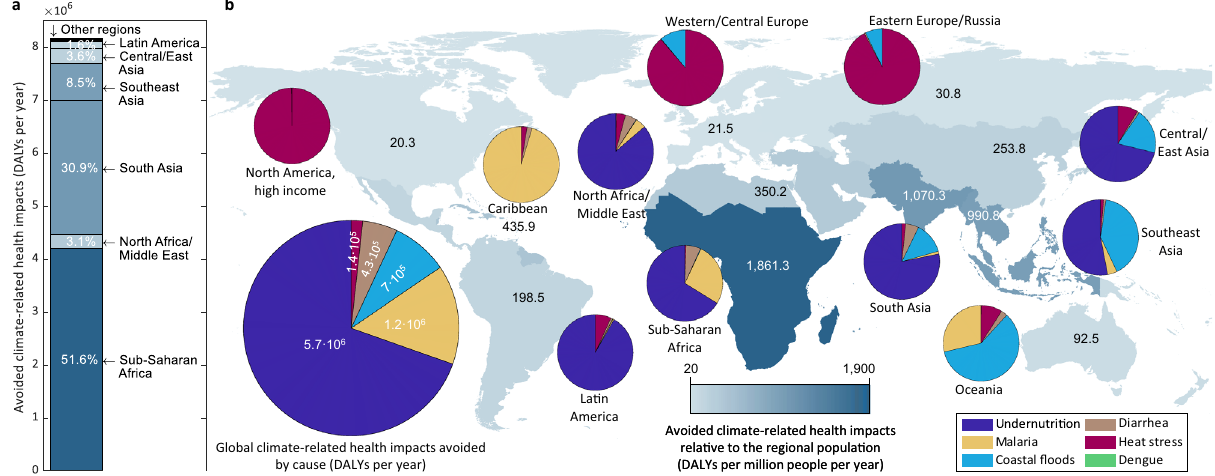
Fig. 4 Climate-related health effects avoided with respect to the baseline in the High-Temperature Liquid Sorbent Direct Air Carbon Capture and Storage (HTLS-DACCS) scenario based on wind energy and CO 2 mineralization with seawater. a Geographical distribution of the prevented climate- related health impacts, expressed in Disability-Adjusted Life Years (DALYs) per year. b Prevented climate-related health impacts relative to the size of the regional population (DALYs per million people per year) and distribution of the avoided health impacts by cause (DALYs per year). The distribution of the averted climate-related health impacts by region and cause remains constant across the studied scenarios despite the change in the impact